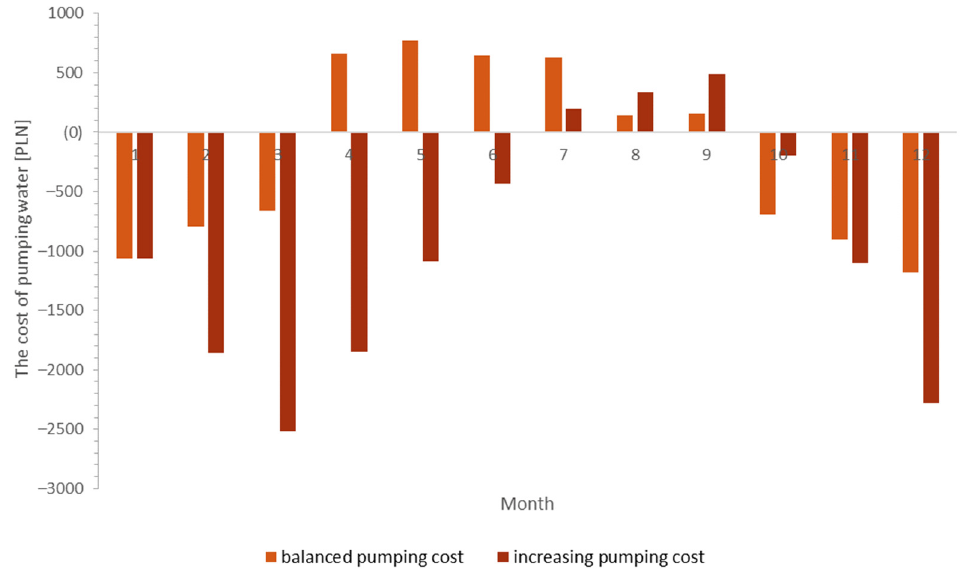
Figure 10. The costs of pumping water in the WDS are balanced by the production of electricity by the PV installation.